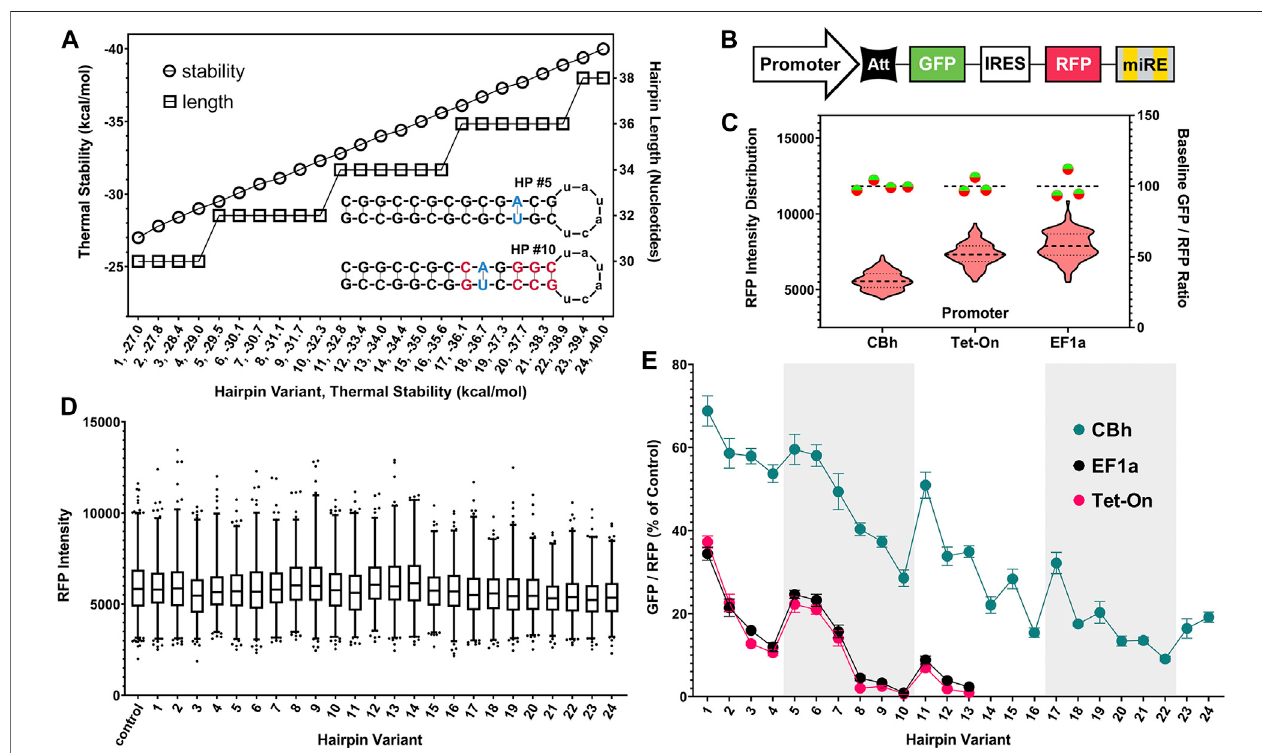
FIGURE 2 | Generation of hairpin structure library and assessment of performance as translational attenuators using fl uorescence ratiometry. (A) Hairpin (HP) “ attenuator ” sequence stability gradient pictured (circles, left axis) with corresponding length (squares, right axis). Thermal stability is the primary determinant of attenuator function and is inversely correlated with protein translation from paired genes. Inset structure diagrams highlight sequence shuf fl ing used to produce attenuators of differing stability, but with identical length and GC content. The fi nal subset tested was selected from a comprehensive list of > 5,700 unique sequences, which maximized uniformity of coverage within the functionally relevant range. (B) Simpli fi ed schematic of knockdown-replacement plasmid (pKDR) construct, displayed here with a GFP (mClover3) gene in place of the “ rescue ” gene. Validation experiments to ratiometrically assess ef fi cacy of hairpins as translational attenuators were carried out with non-targeting luciferase shRNA cloned into the 3 ′ endogenous mir30 (miRE) cassette. (C) Baseline performance of CBh, EF1a, and tetracycline-inducible(Tet-On) promotersafter transientplasmidtransfection inHEK293T cells. Violinplot displays RFP(mScarlet) intensitydistribution acrossallimages taken for each promoter (left Y axis). Baseline un-attenuated GFP/RFP intensity ratios are plotted on the right Y axis (Green/Red circles). While base expression strength differsbetweenpromoters, each un-attenuated controlconstruct provides aconsistent internal baselinemeasurement. (D) IRES-mediated translation isunimpactedby 5 ′ hairpins, as RFP intensity is uniform across the entire range of attenuator sequences after transient plasmid transfection in HEK293T cells. (E) Increasing hairpin stability attenuates GFP translation in non-linear, but highly internally consistent and reproducible manner. Alternating white and gray regions on the graph indicate changesinlengthsofhairpin(30,32,34,36,and38fromlefttoright).Ratiosforeachpromoteraredisplayedasthepercentoftheirownun-attenuatedcontrol.Whilethe CBh promoter is resistant to attenuation, all promoters mirrored a nonlinear performance trend after transient plasmid transfection in HEK293T